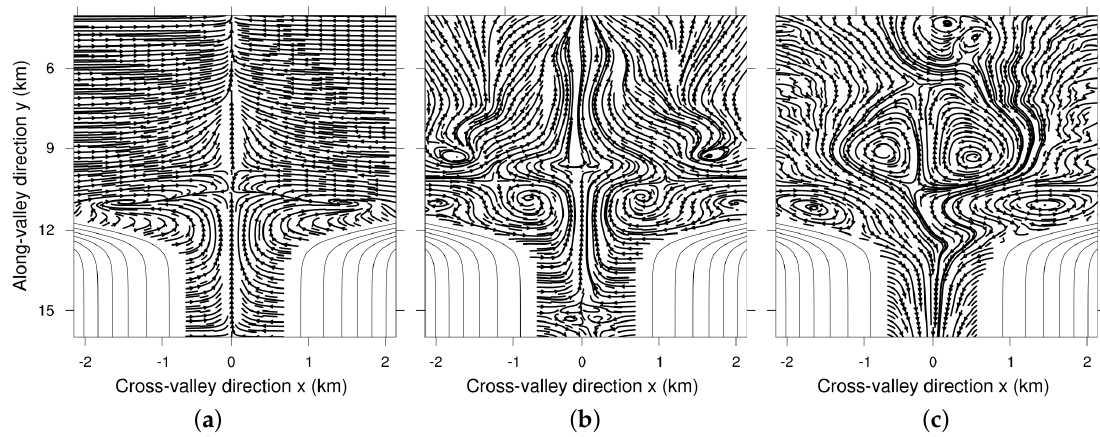
Figure 8. Zoom on the upper part of the valley for P2 displaying streamlines overlaid with contour lines of the terrain height using a 50 m interval. The velocity field is vertically averaged over the first 30 m above the valley bottom and averaged in time over ( a ) 60–120 min, ( b ) 120–180 min and ( c ) 240–300